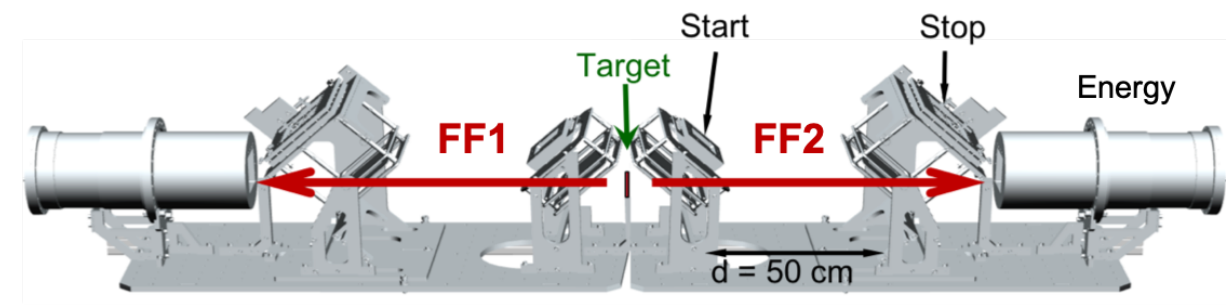
Figure 1. Drawing of the two-arm-FALSTAFF-spectrometer. Each arm is made of two ToF detectors followed by an energy detector to collect the remaining kinetic energy of the fragments. At the moment the first arm has been